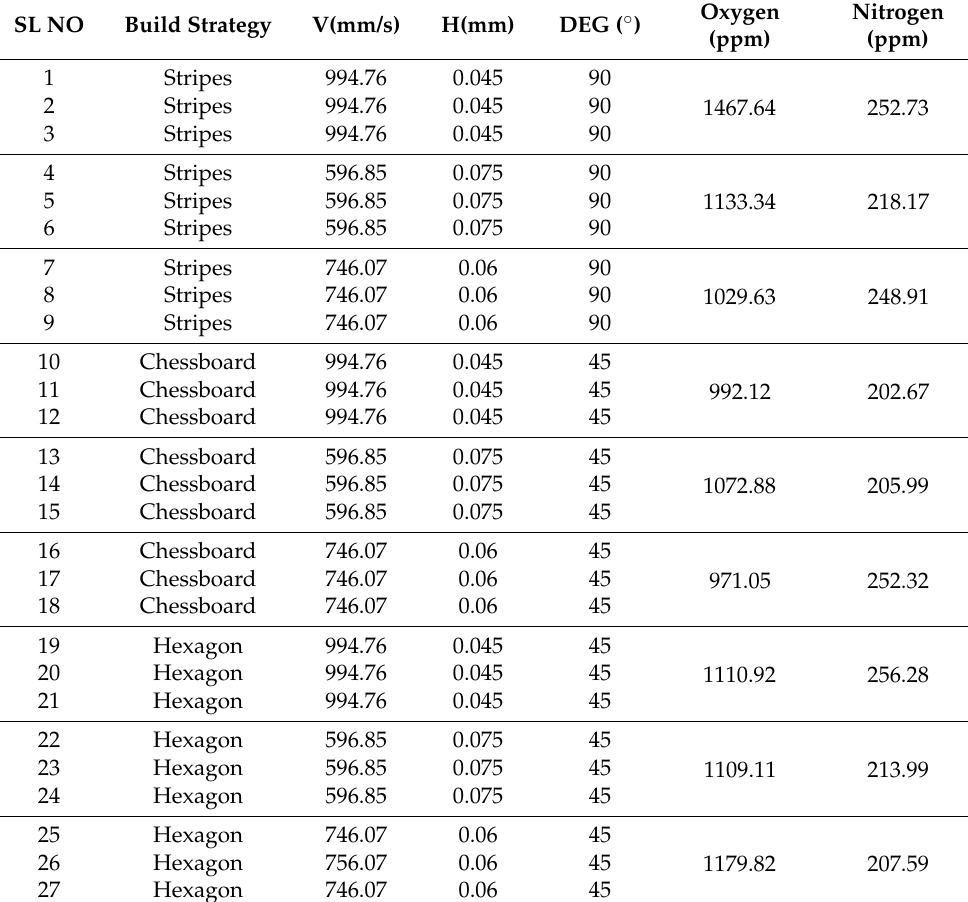
Table 2. Process parameter and gas